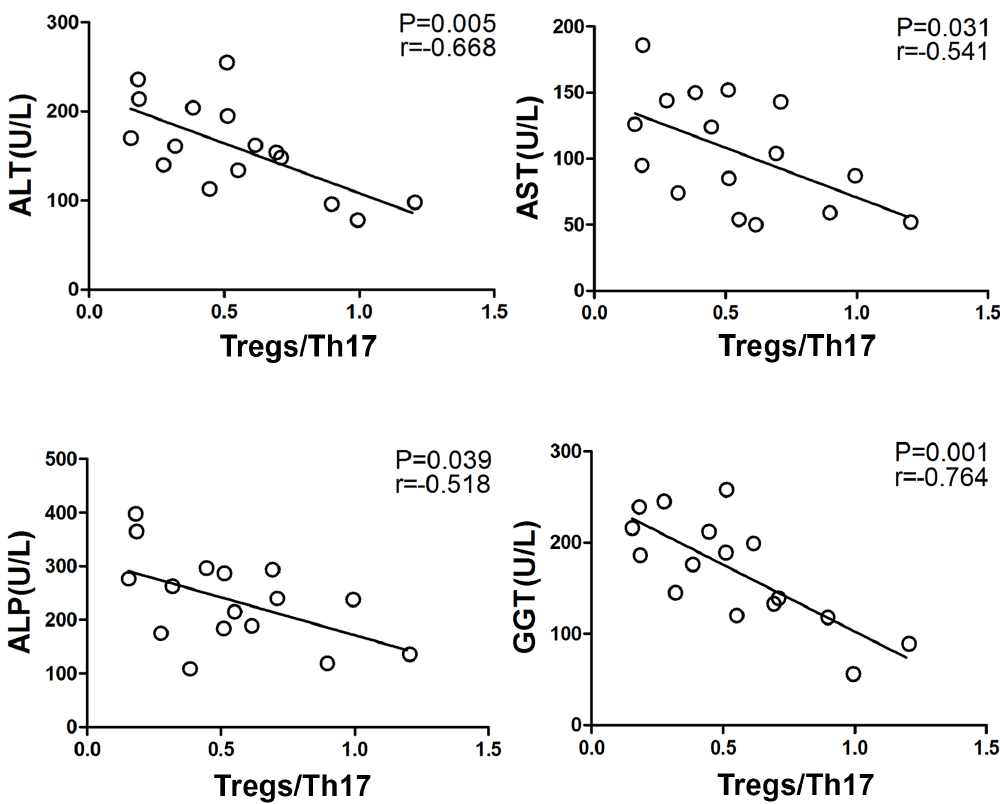
Figure 2. Tregs/Th17 ratio is correlated with the serum levels of ALT, AST, ALP and GGT. We analyzed the correlation between the ratio of circulating Tregs/Th17 and the biochemical indices for liver damage, ALT, AST, ALP and GGT, in the 16 patients with acute allograft rejection. Negative correlations were found between the ratio of circulating Tregs/Th17 and the levels of ALT, AST, ALP, and GGT ( P , 0.05).